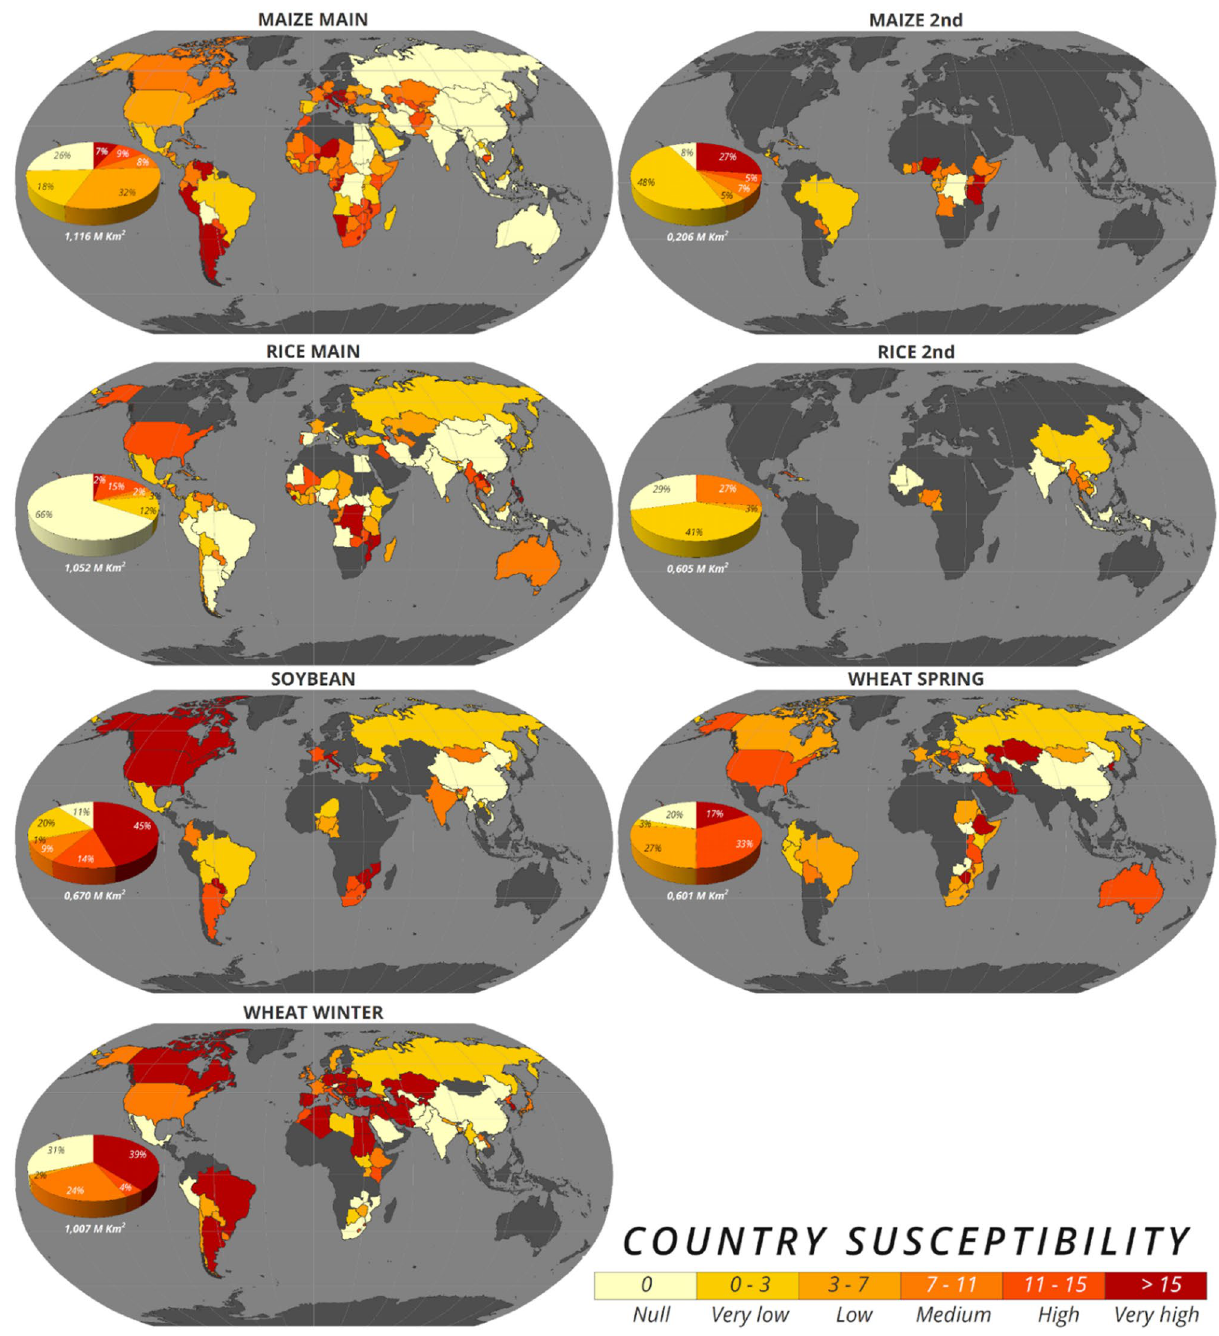
Figure 2. Country susceptibility to drought-low yield association. Average occurrence, for each country, of SPEI duration-timing combinations with SPEI ≤ − 1 across all the years with SYI ≤ − 1. The values obtained from all cropping systems are classified into susceptibility classes considering five quantiles while zero is presented separately (light yellow) and distinguished from “no data” land areas (dark grey). Pie diagram represents the susceptibility classes’ share (within cultivated surface) among the coloured countries (i.e., excluding no data areas); the global cultivated area is reported below the pie in Km 2